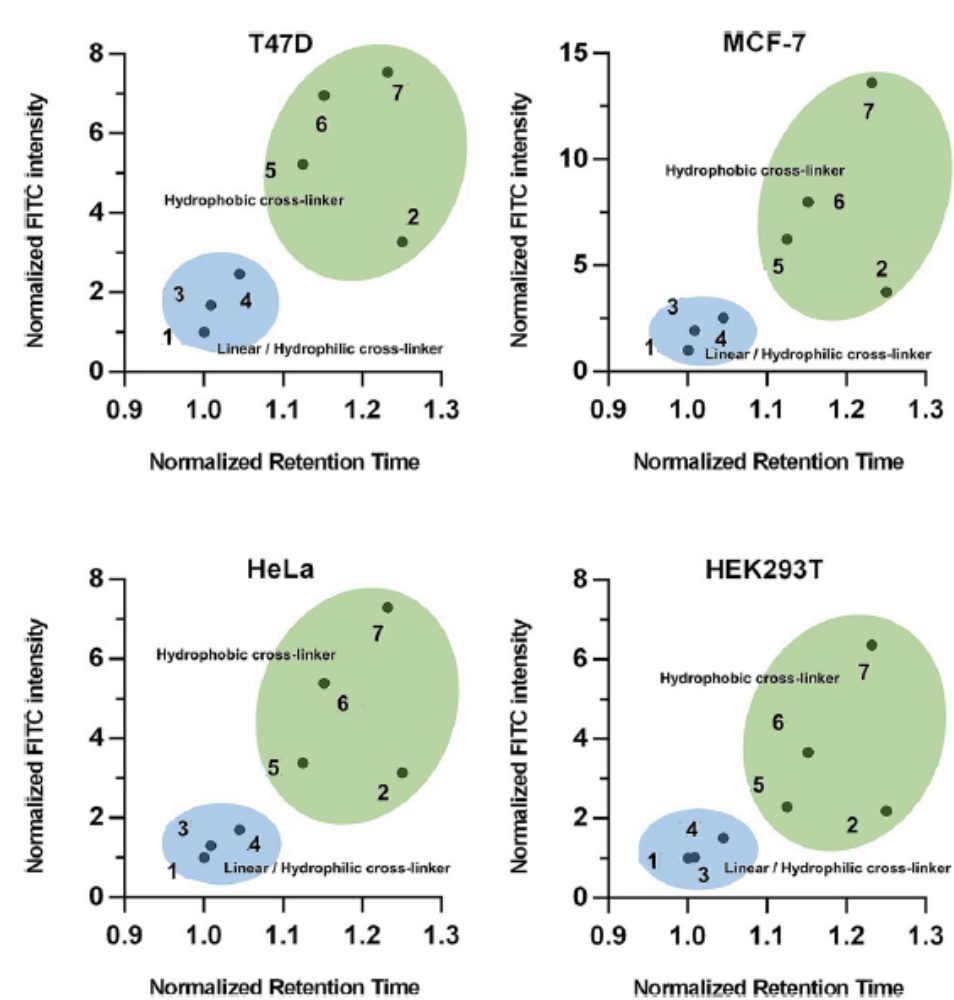
Figure 8. Normalized FAM intensity versus normalized retention time of FAM-labelled peptides L1b - L7b by using flow cytometry analysis in different cell lines and reversed-phase liquid chromatography. FAM intensity and retention times were normalized with respect to the linear peptide ( 1 ) ( 1 = unstapled; 2 = all-hydrocarbon-; 3 = lactam-; 4 = triazole-; 5 = vinyl sulfide-; 6 = xylene-; 7 = perfluoroaryl-)